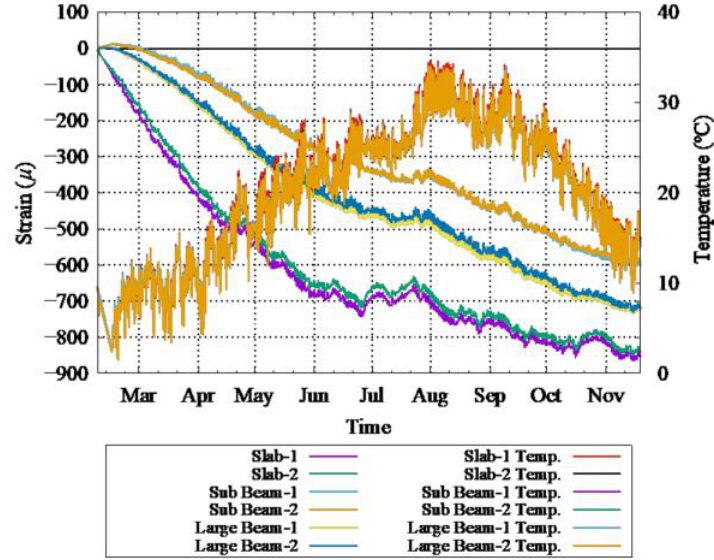
Figure A1. Shrinkage and temperature of the dummy